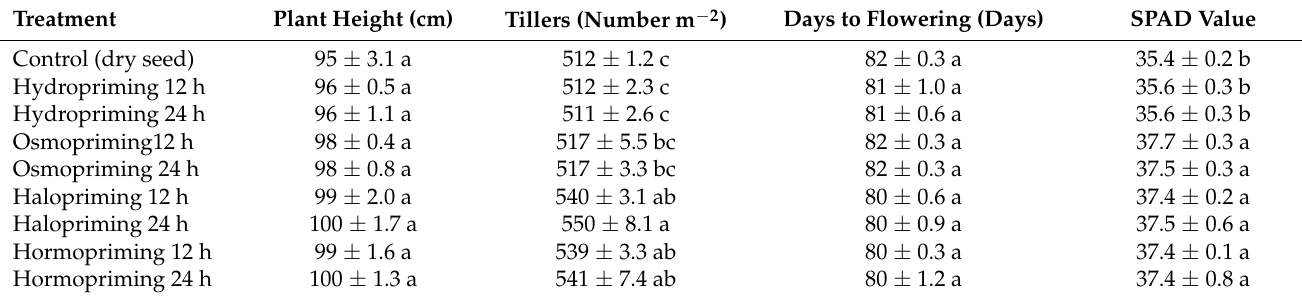
Table 4. Plant height, tiller number, days to flower and SPAD value as affected by different seed priming in conventional DSR establishment method during 2018 at Ludhiana,